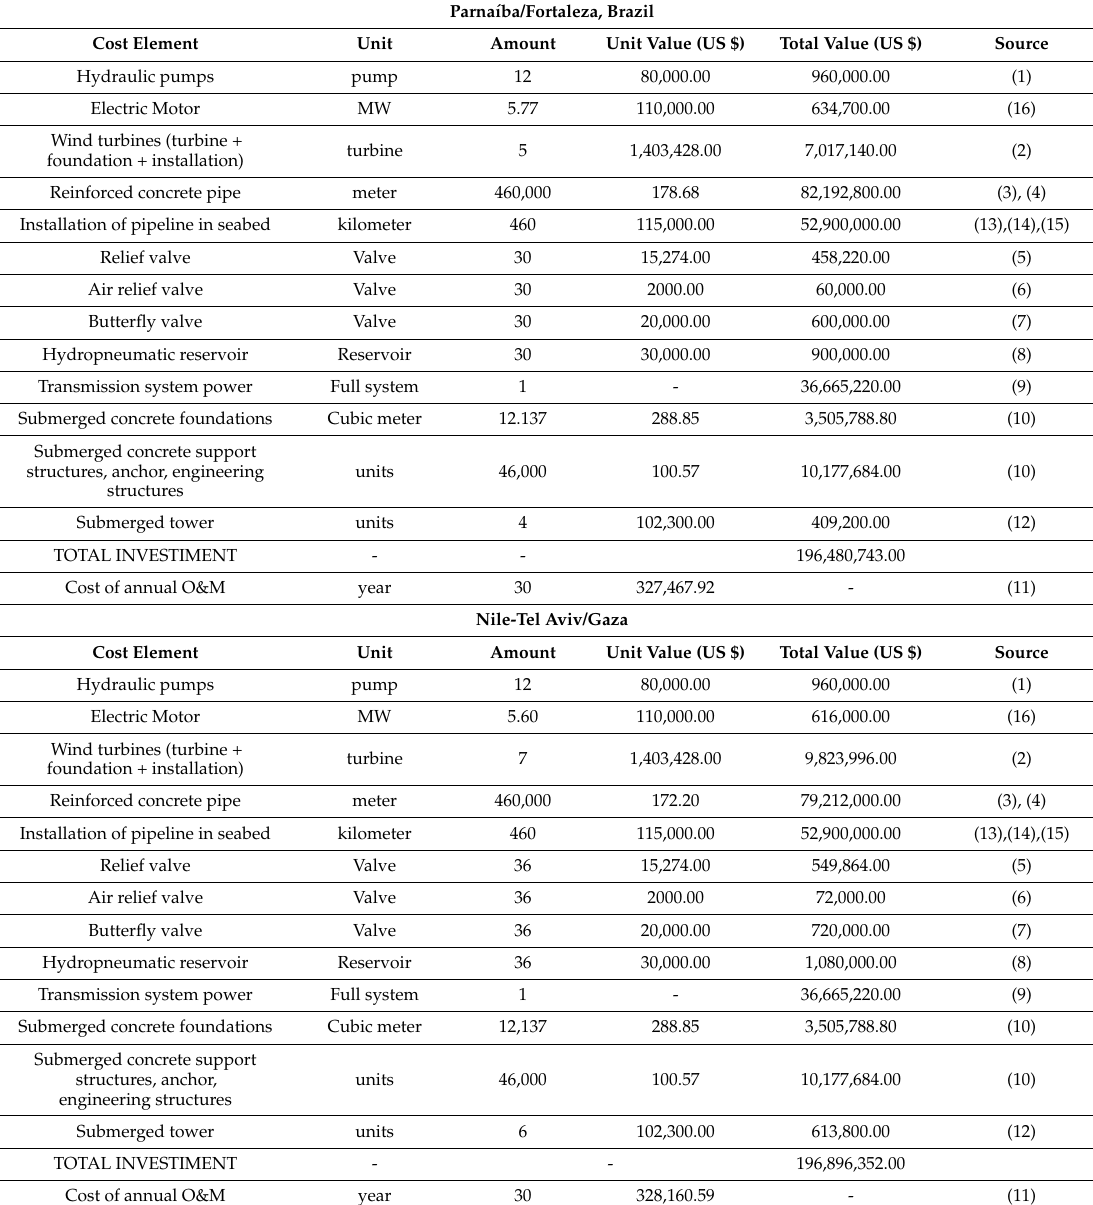
Table 16. Estimated Cost of Investment for pipelines-Scenario 2 (81